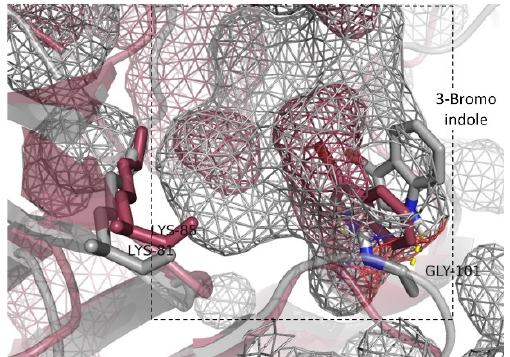
Figure 8. Superimposed homology model of SpH2 (grey) and SpH1 (red) with the docked 3-bromoindole after 1 ns MD simulation. The active site cavity is shown in wireframe (surrounded by a dashed-line box). In both cases, an H-bond is formed between indole NH and Gly442 in SpH2 and Ser445 in SpH1.